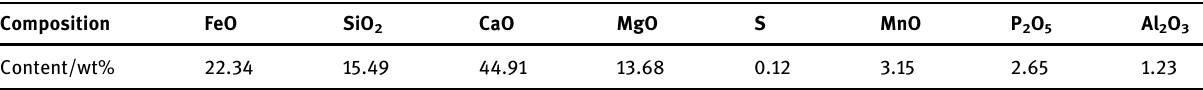
Table 1: Composition of the slag used in this experiment